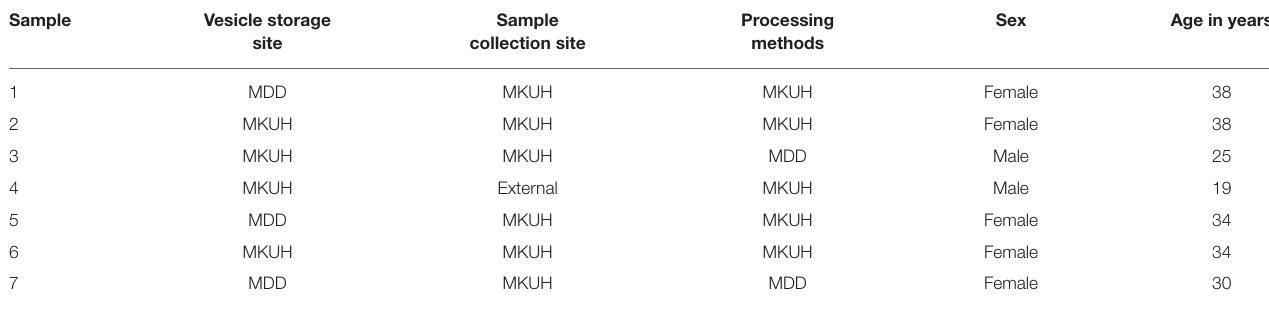
TABLE 2 | Seven urine samples procured for the systematic investigation of confounding factors.